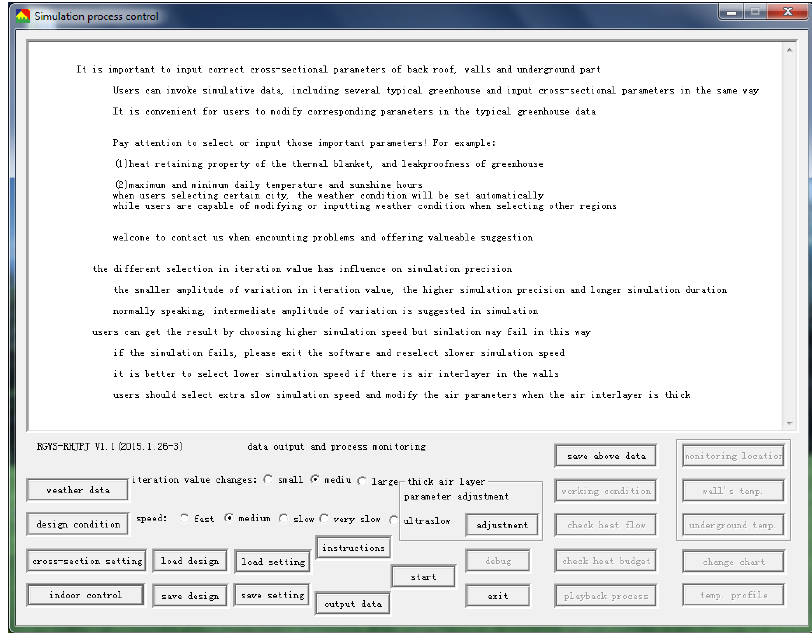
Figure 2. Starting interface of the SOGREEN model.